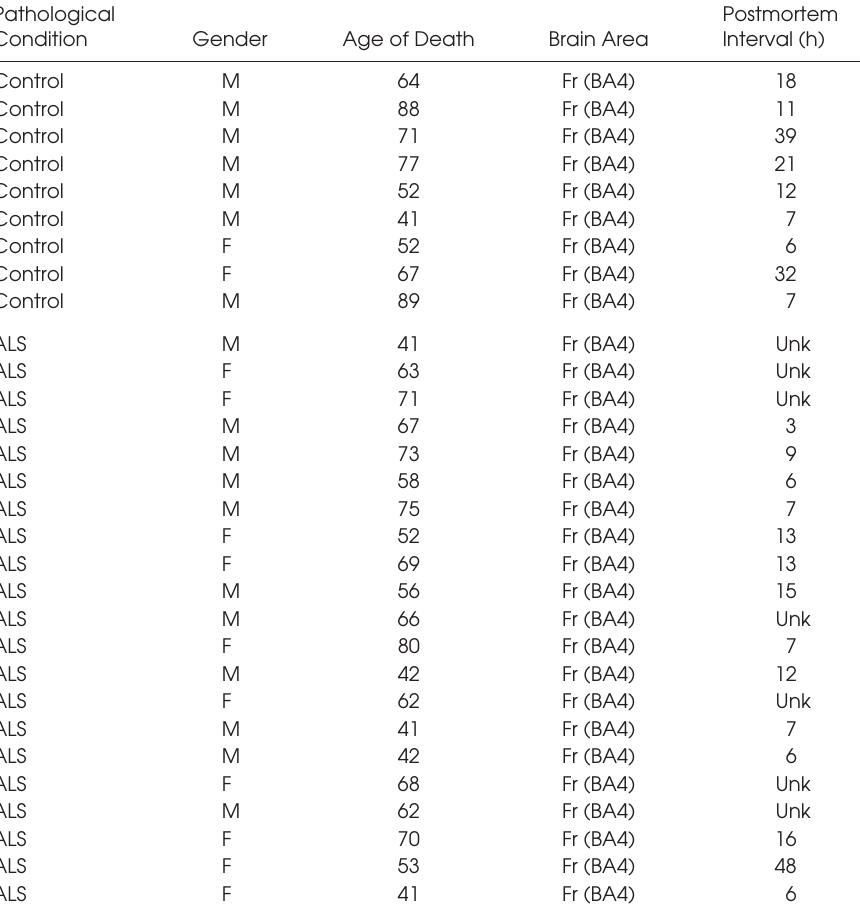
table 1. Frontal cortex tissue analyzed in this